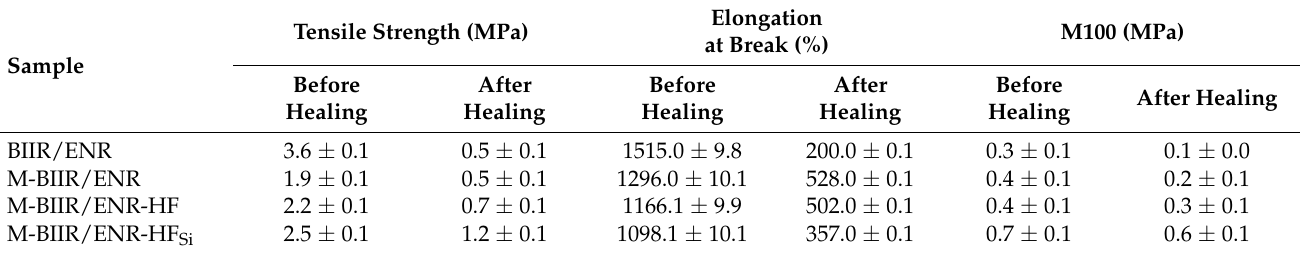
Table 3. Mechanical properties and healing efficiency of M-BIIR compounds mixed with ENR- CNT/CB composites for the unfilled and filled TESPT silane coupling agent.